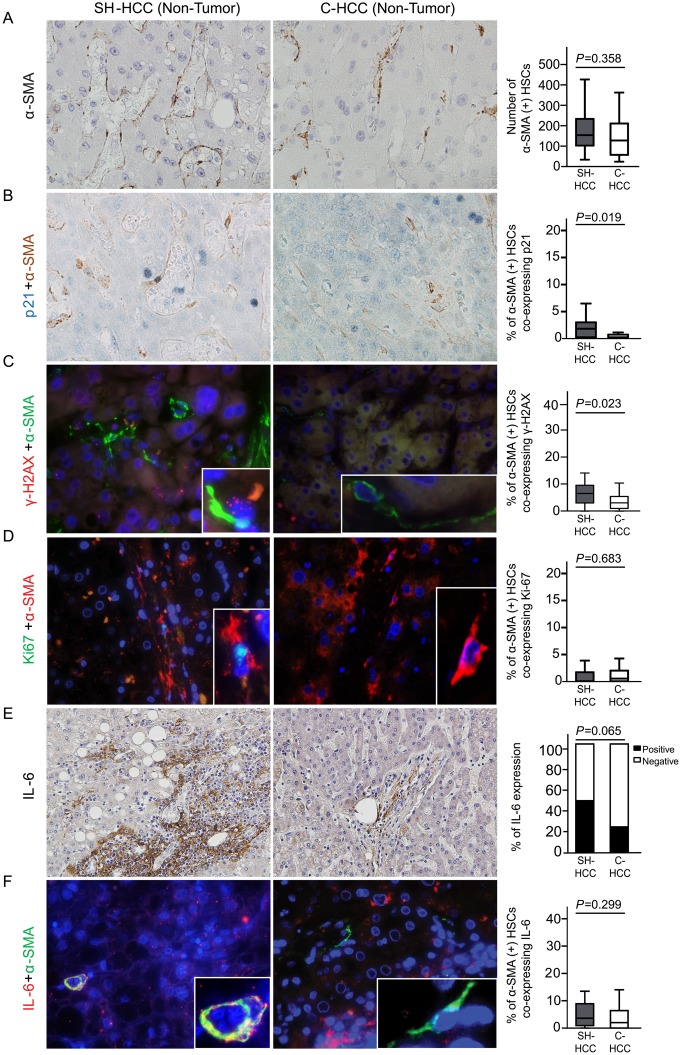
Non-tumoral hepatic stellate cells (HSCs) expressing p21Waf1/Cip1, γ-H2AX, and IL-6 in non-tumoral regions of SH-HCCs and C-HCCs.(A) Non-tumoral HSCs expressing α-SMA show no differences in number between the two groups. (B) Double immunohistochemical stain reveals nuclear p21Waf1/Cip1 in blue (arrow) and cytoplasmic α-SMA in brown. Non-tumoral HSCs co-expressing p21Waf1/Cip1 and α-SMA are more frequently seen in non-tumoral regions of SH-HCCs compared to that for C-HCCs. (C) Double immunofluorescence images of γ-H2AX (red) and α-SMA (green). Non-tumoral HSCs co-expressing γ-H2AX and α-SMA are higher in non-tumoral regions of SH-HCCs, compared to that for C-HCCs. (D) Double immunofluorescence images of Ki-67 (green) and α-SMA (red) showing no difference between groups. (E) IL-6 expression, detected by immunohistochemistry, is relatively higher in the stroma of non-tumoral regions of SH-HCCs, compared to that for C-HCCs. (F) Double immunofluorescence of IL-6 (red) and α-SMA (green) show no difference between groups. Nuclei were stained with DAPI. The merged fluorescence images of boxed areas are further magnified in the insets. Box plot graphs in the right column demonstrate comparisons between the two groups (A-D, F, original magnification x400; E, original magnification x200). α-SMA, α-smooth muscle actin.